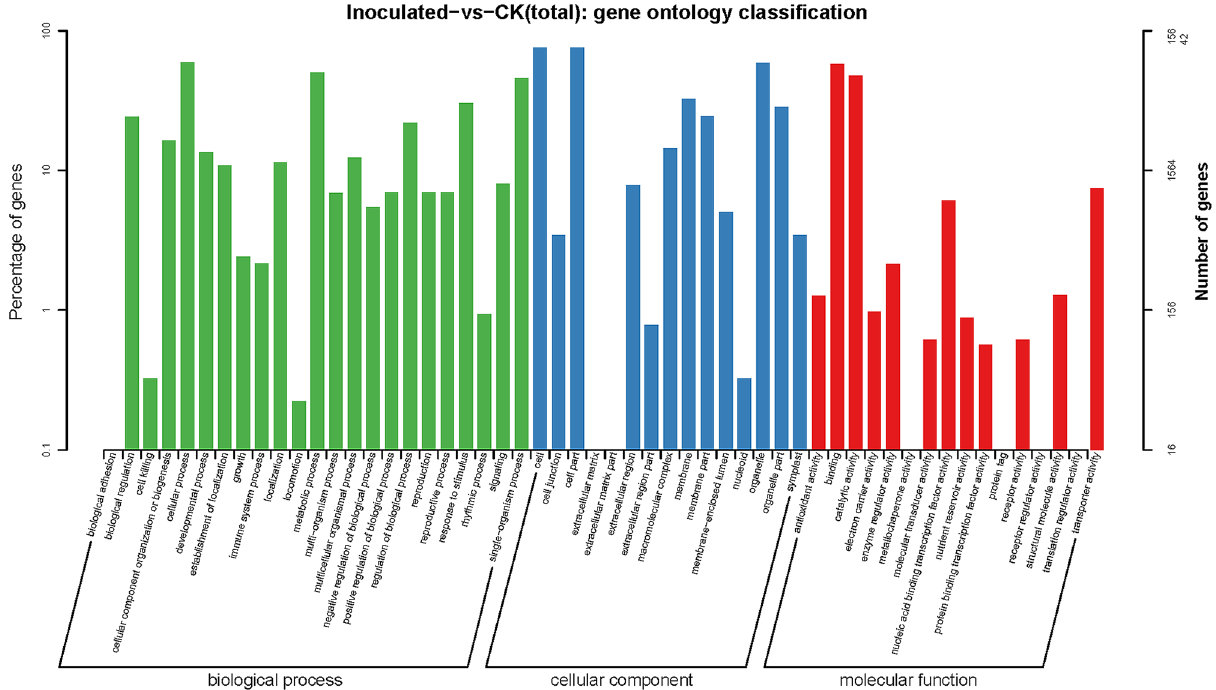
Figure 6. Gene ontology (GO) enrichment analysis of significant DEGs of T. controversa -infected and mock libraries. Annotations are grouped by biological process, cellular component, and molecular function. CK indicates mock plants, and Inoculated indicates plants infected by T.